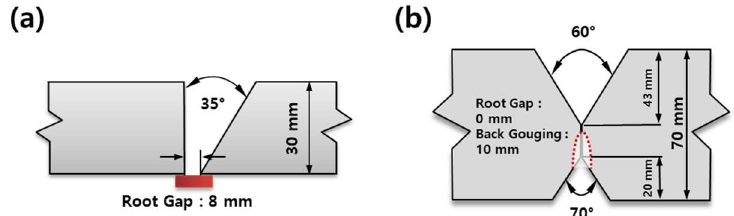
Figure 1. ( a ) Single beveled groove of the 30 mm thick plate; ( b ) double V groove of the 70 mm thick plate.